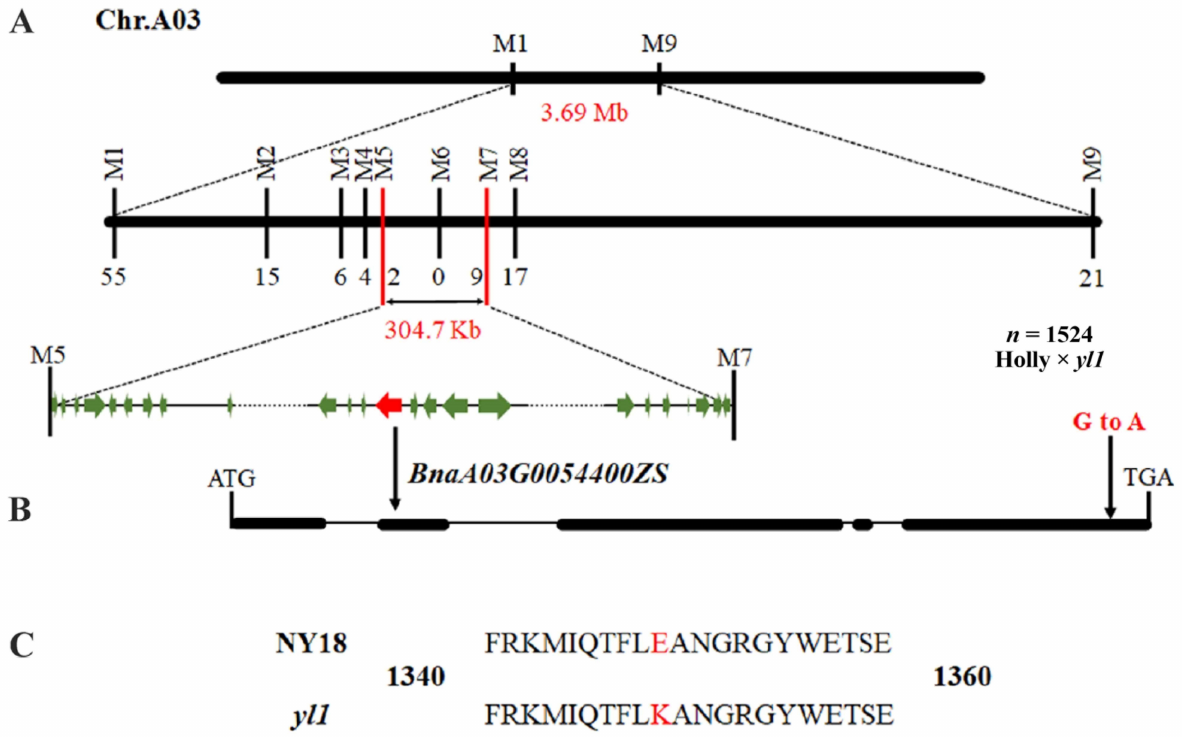
Figure 3. Fine mapping of the BnA03.Chd gene in (Holly × yl1 ) F 2 population. ( A ) The BnA03.Chd locus was fine-mapped in a 304.7 kb interval containing 58 genes using 1524 chlorophyll-deficient individuals. ( B ) The BnaA03G0054400ZS was the final candidate gene and had an SNP (G to A) of the gene. ( C ) The SNP caused the change of glutamic acid at 1349th position to